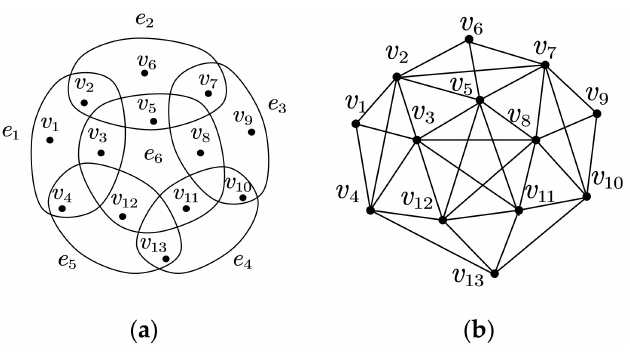
Figure 1. The hypergraph and two-section graph of its transformation. ( a ) Hypergraph and ( b ) two- section